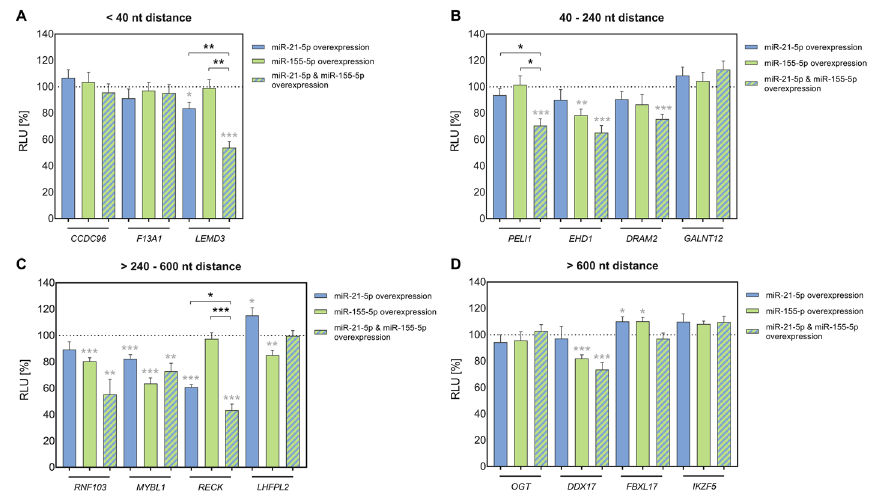
Fig. 2 Analysis of miRNA cooperativity by HiTmIR assays. The 3’UTR sequences of 15 putative cooperative targets of miR‑21‑5p and miR‑155‑5p were cloned into pMIR‑RNL‑TK reporter plasmid and analyzed by semi‑automated HiTmIR dual luciferase reporter assays. MiRNA induced effects on firefly luciferase activity were determined upon overexpression of only miR‑21‑5p or only miR‑155‑5p or upon co‑expression of both miRNAs. For representation, the analyzed genes were categorized into four groups regarding the distances between neighboring miR‑21‑5p and miR‑155‑5p binding sites (< 40 nt ( A ), 40‑240 nt ( B ), > 240–600 nt ( C ), > 600 nt ( D )). Relative luciferase units (RLU) were related to the activity of an empty reporter control (pMIR‑RNL‑TK; under the respective miRNA condition) and are shown as the mean result ( of the mean ( SEM)) of four independent experiments that were conducted in technical duplicates. ± Statistical evaluation was performed in comparison to the empty reporter control (gray asterisks) or for the co‑expressional conditions in comparison to the effects upon single miRNA overexpression of miR‑21‑5p and miR‑155‑5p (black asterisks), respectively. Significant p‑values after FDR adjustment are denoted (*p **p < 0.01, *** p <